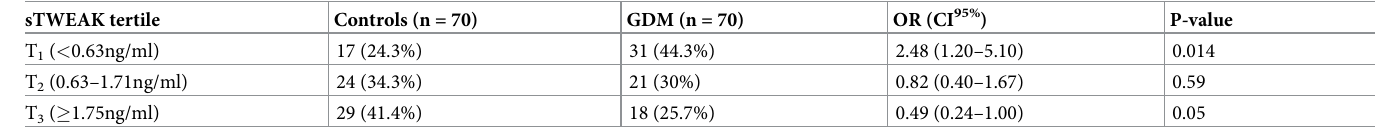
Table 1. Pregnant women in early pregnancy with plasma levels of sTWEAK in the lowest tertile had increased risk of being diagnosed with GDM. A tendency of decreased risk of GDM could be seen in the highest sTWEAK tertile. sTWEAK